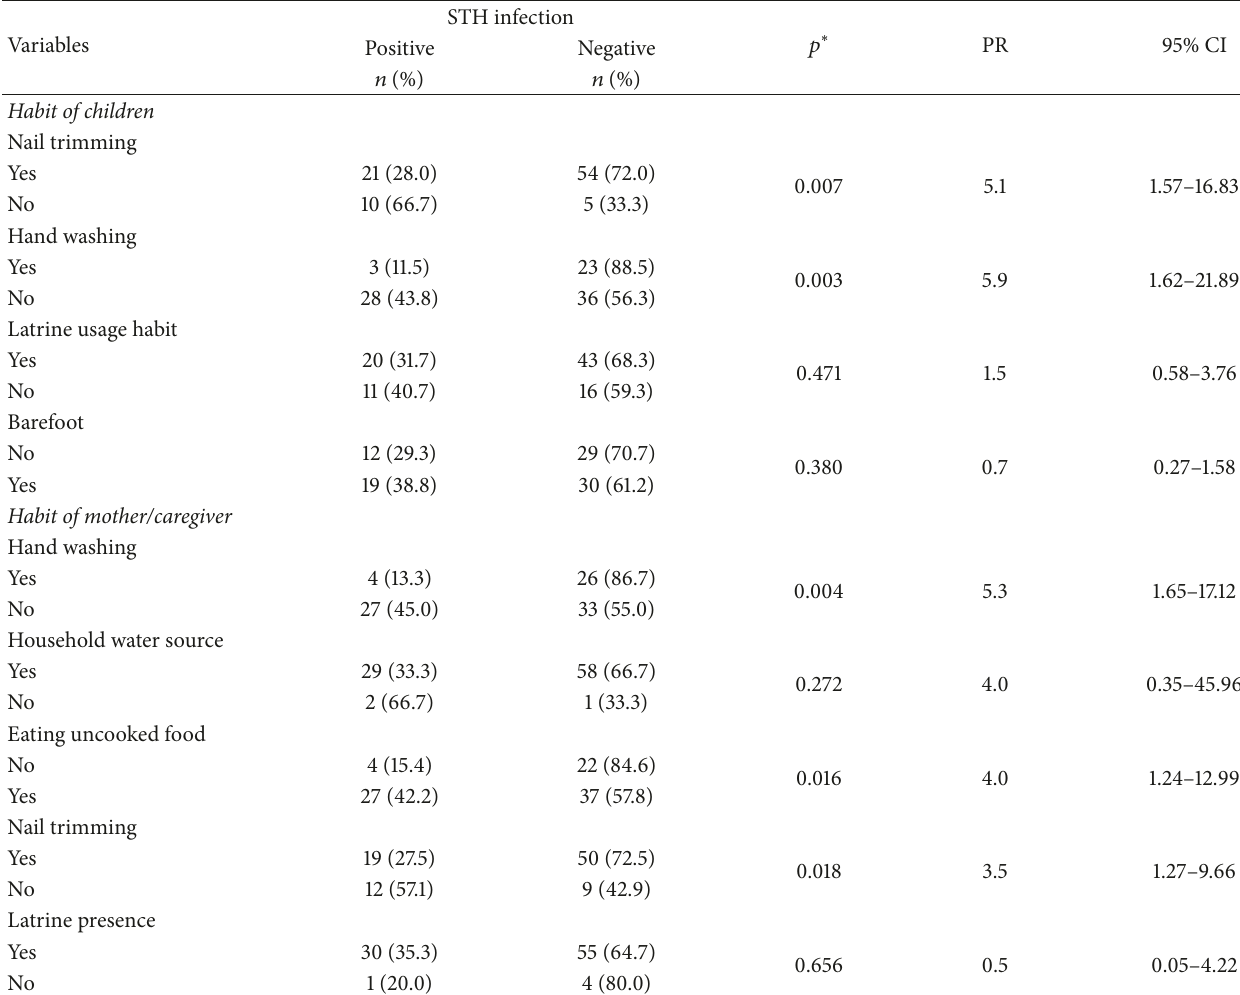
Table 3: Risk factors of STH infection in preschool children.